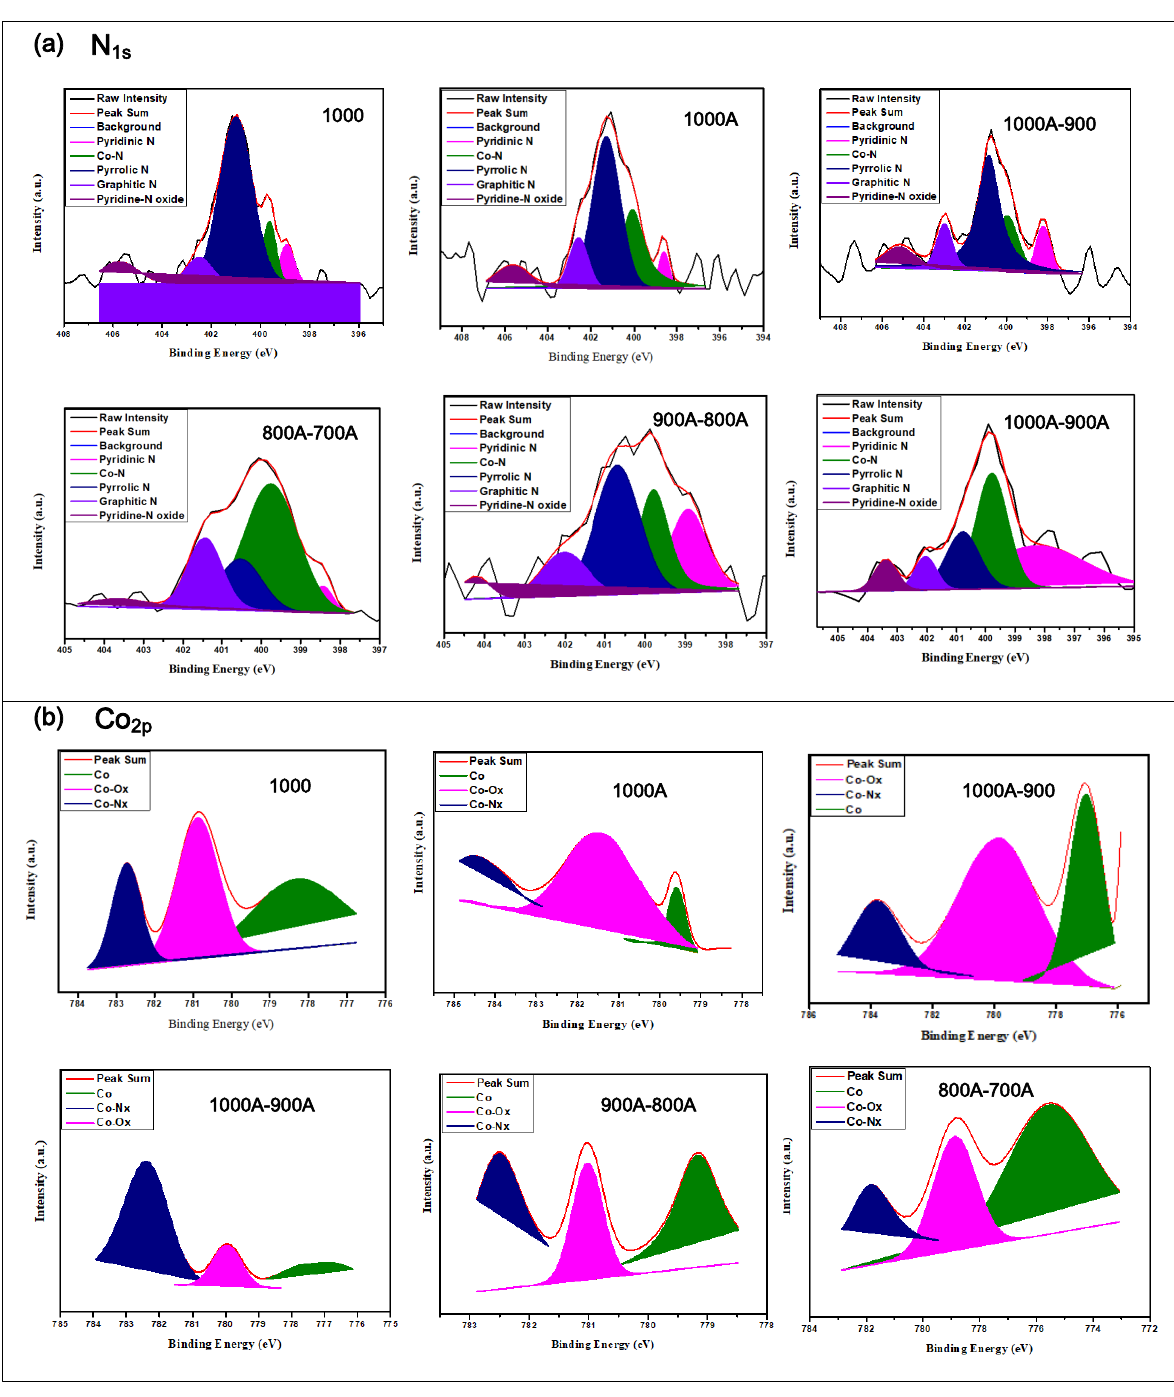
Figure 2. XPS spectra of various Co-N-C catalysts. ( a ) N 1s , ( b ) Co 2p .